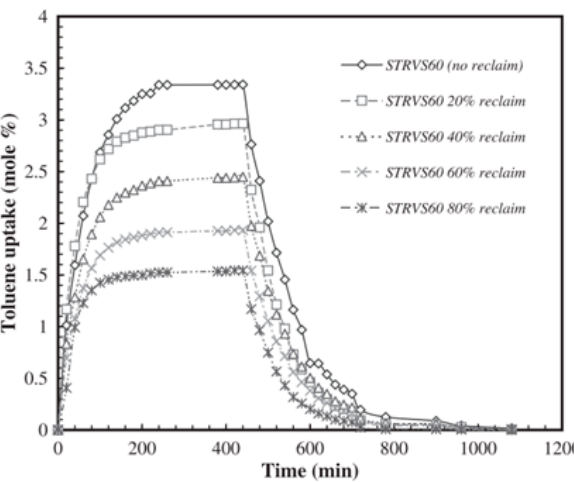
Figure 37. E ff ect of RTR content on the toluene sorption (25 ◦ C) and desorption (70 ◦ C) curves of Figure 37. Effect of RTR content on the toluene sorption (25 °C) and desorption (70 °C) curves of RTR/NR(STRVS60) compounds (reproduced with permission from [133]). RTR / NR(STRVS60) compounds (reproduced with permission from